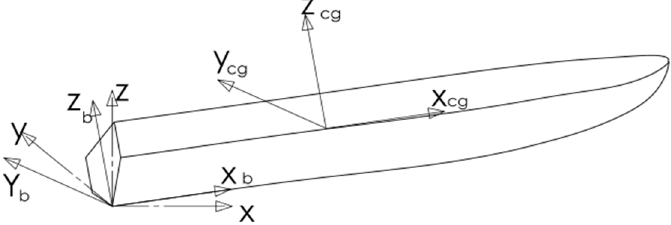
Figure 17. Boat coordinate systems.